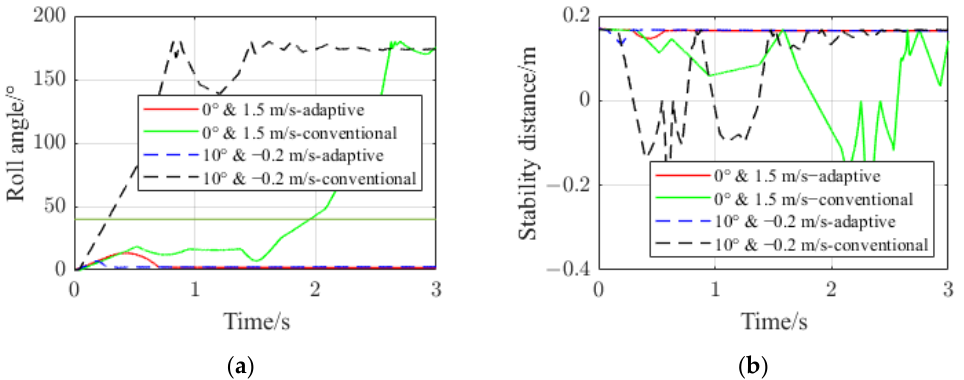
Figure 9. The landing simulation curves of adaptive landing gear and conventional landing gear with different combinations of vertical velocity and slope angle: ( a ) represents the roll angle of the rotorcraft; ( b ) represents the stability distance.